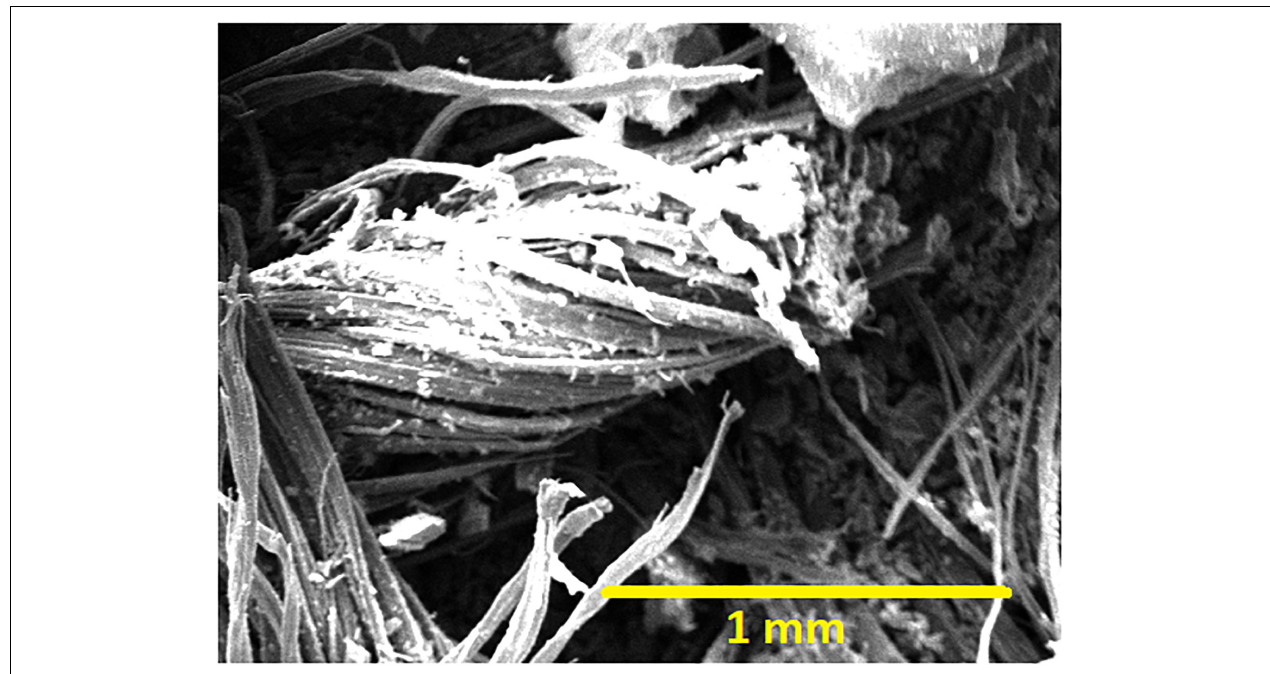
FIGURE 3 | SEM image of jute